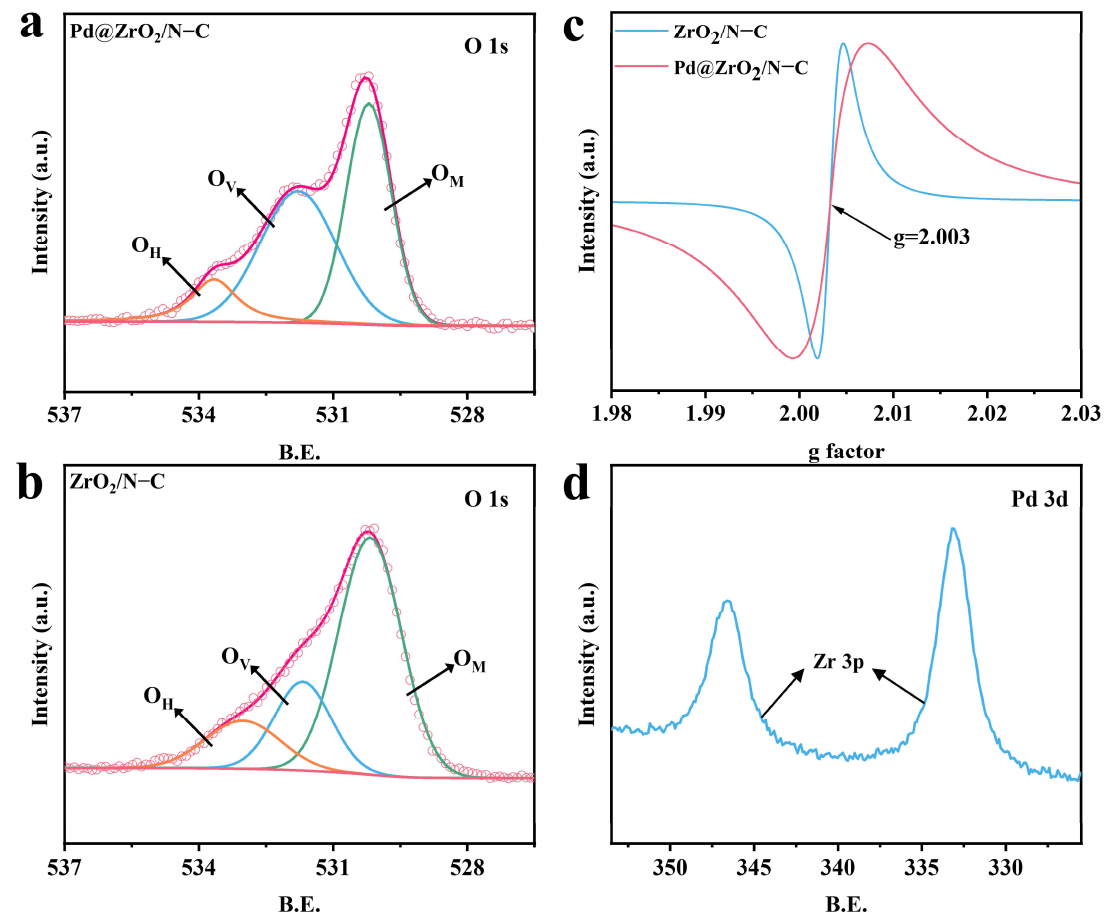
Figure 2. ( a ) O 1s XPS spectrum of Pd@ZrO 2 /N–C. ( b ) O 1s XPS spectrum of ZrO 2 /N–C. ( c ) EPR